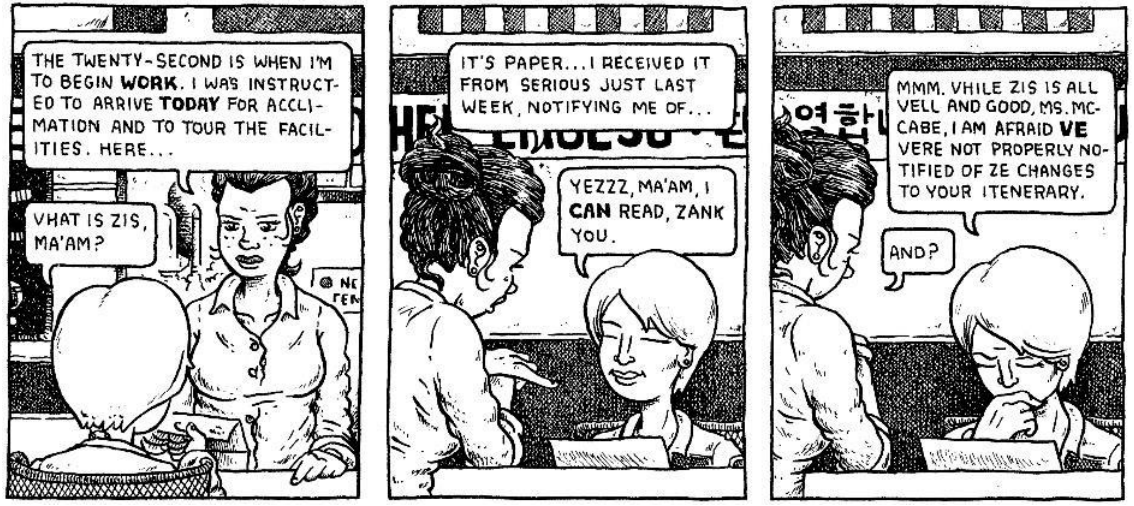
Figure 1. From Cotter, Nod Away , 52. Copyright, 2016, by Joshua W